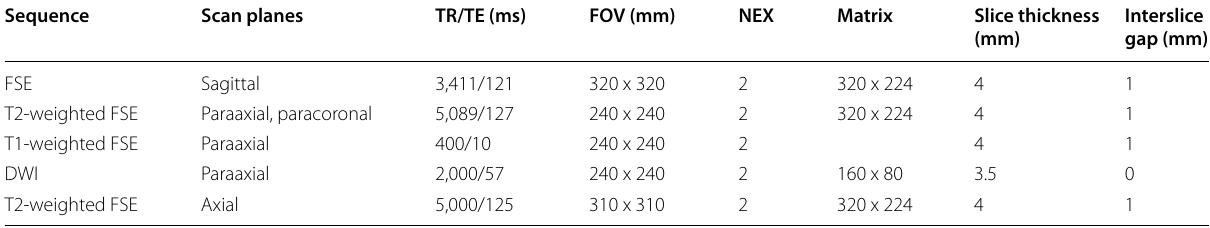
b values DWI were 0, 500, and 1,000 s/mm 2 DWI Diffusion-weighted imaging, FA Flip angle, FOV Field of view, FSE Fast spin-echo, NEX Number of excitations, TE Echo time, TR Repetition time